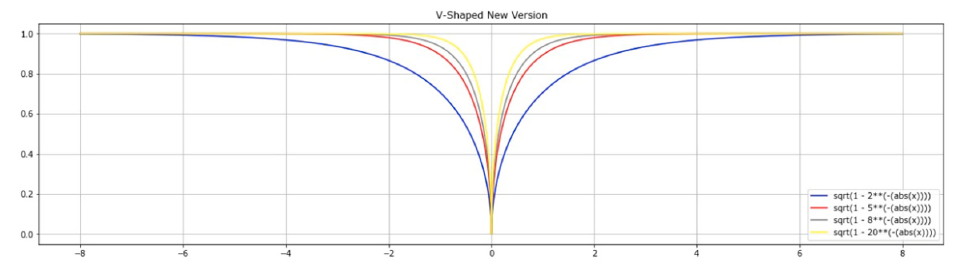
Figure 9. New version V-shaped transfer function (New V 1–New V 4).